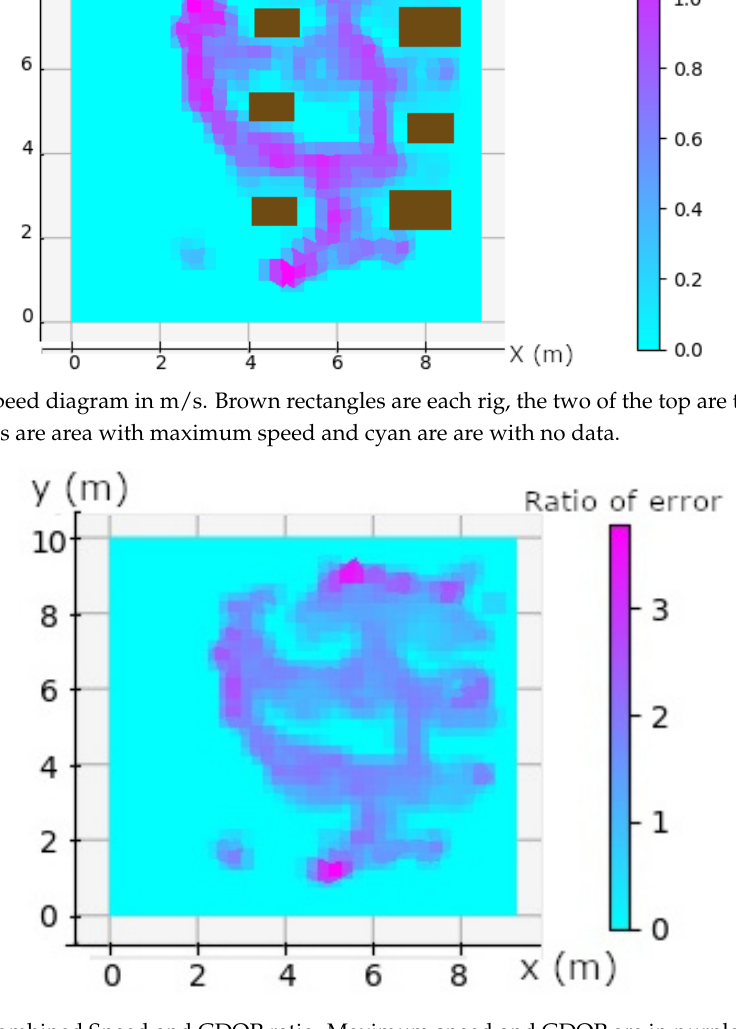
Figure 11. Combined Speed and GDOP ratio. Maximum speed and GDOP are in purple (~4); cyan no data